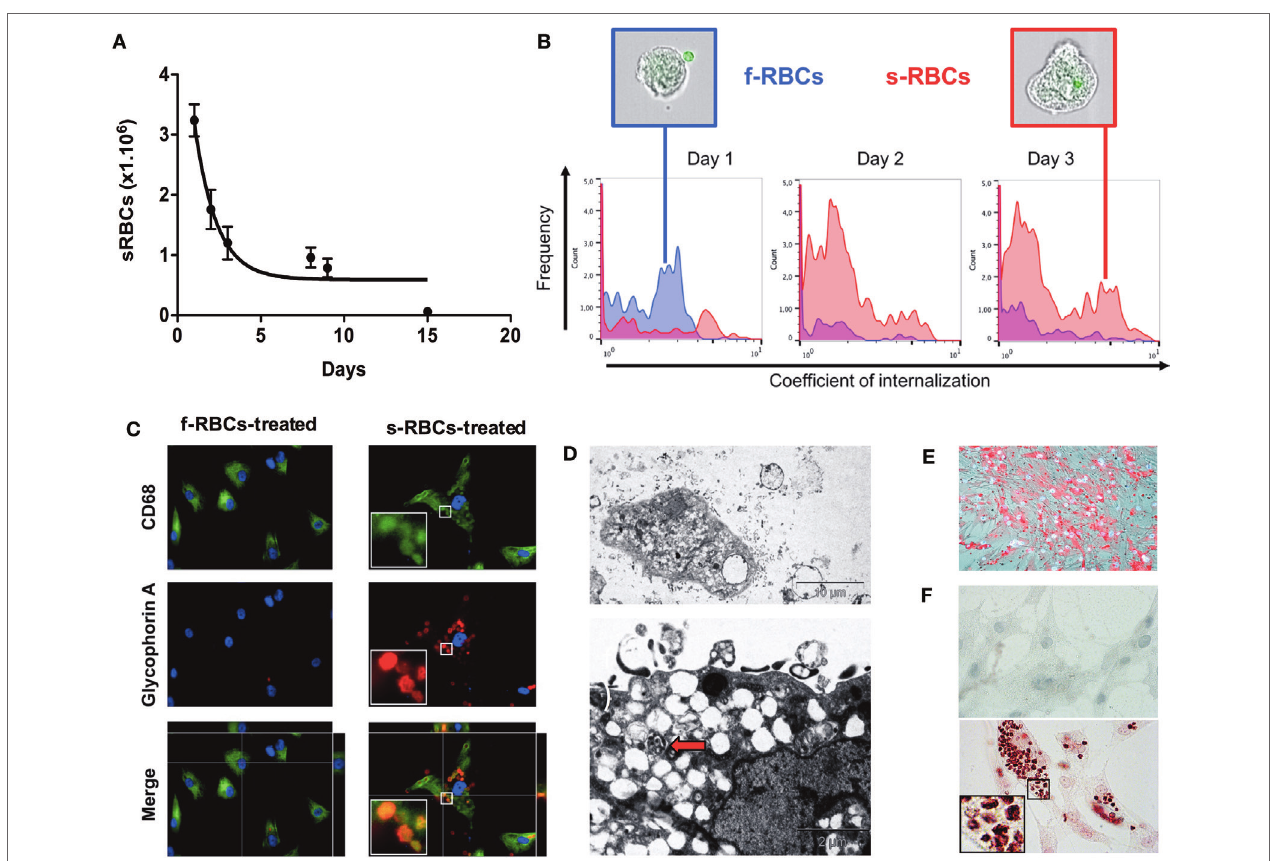
FigUre 6 | Vascular smooth muscle cells (vSMCs) phagocytose senescent red blood cells (sRBCs) in vitro . (a) Time course of the diminution of sRBC in the culture medium of vSMCs. The purity of the culture was obtained by dissecting the media form the adventitia. The vSMC nature was validated by α -actin and transgelin staining (not shown) (B) Internalization coefficient of RBCs in resuspended vSMCs at days 1, 2, and 3 ( n = 5 for each time point) calculated by the IDEAS ® software (Amnis). vSMCs with a low coefficient are plotted on left side of each histogram, as observed with fresh RBCs (f-RBCs; blue curves; note the presence of a CFSE + RBC outside of the vSMC in the representative image in the blue-colored frame). vSMCs with a high internalization coefficient will be displayed on the right side, as illustrated with vSMCs co-cultured with senescent RBCs (sRBCs; red curves; an internalized CFSE + RBC can be detected inside the vSMC shown in the red-colored frame). (c) Glycophorin A and CD68 staining of vSMCs incubated with fresh RBCs or with senescent RBCs for 3 days. (D) Electron microscopy of vSMCs that were co-cultured with RBCs. Note that vSMCs internalized sRBCs, formed and released exosomes, retained lipophagic translucent vacuoles that endowed these cells with a foam cell-like phenotype, and displayed phagolysosomes (red arrow). (e) Oil Red O staining of membrane cholesterol from RBCs incorporated by vSMCs. (F) Perls + DAB staining of redox-active iron in vSMCs incubated with fresh RBCs (higher panel, negative) or with senescent RBCs (lower panel, positive) for 3